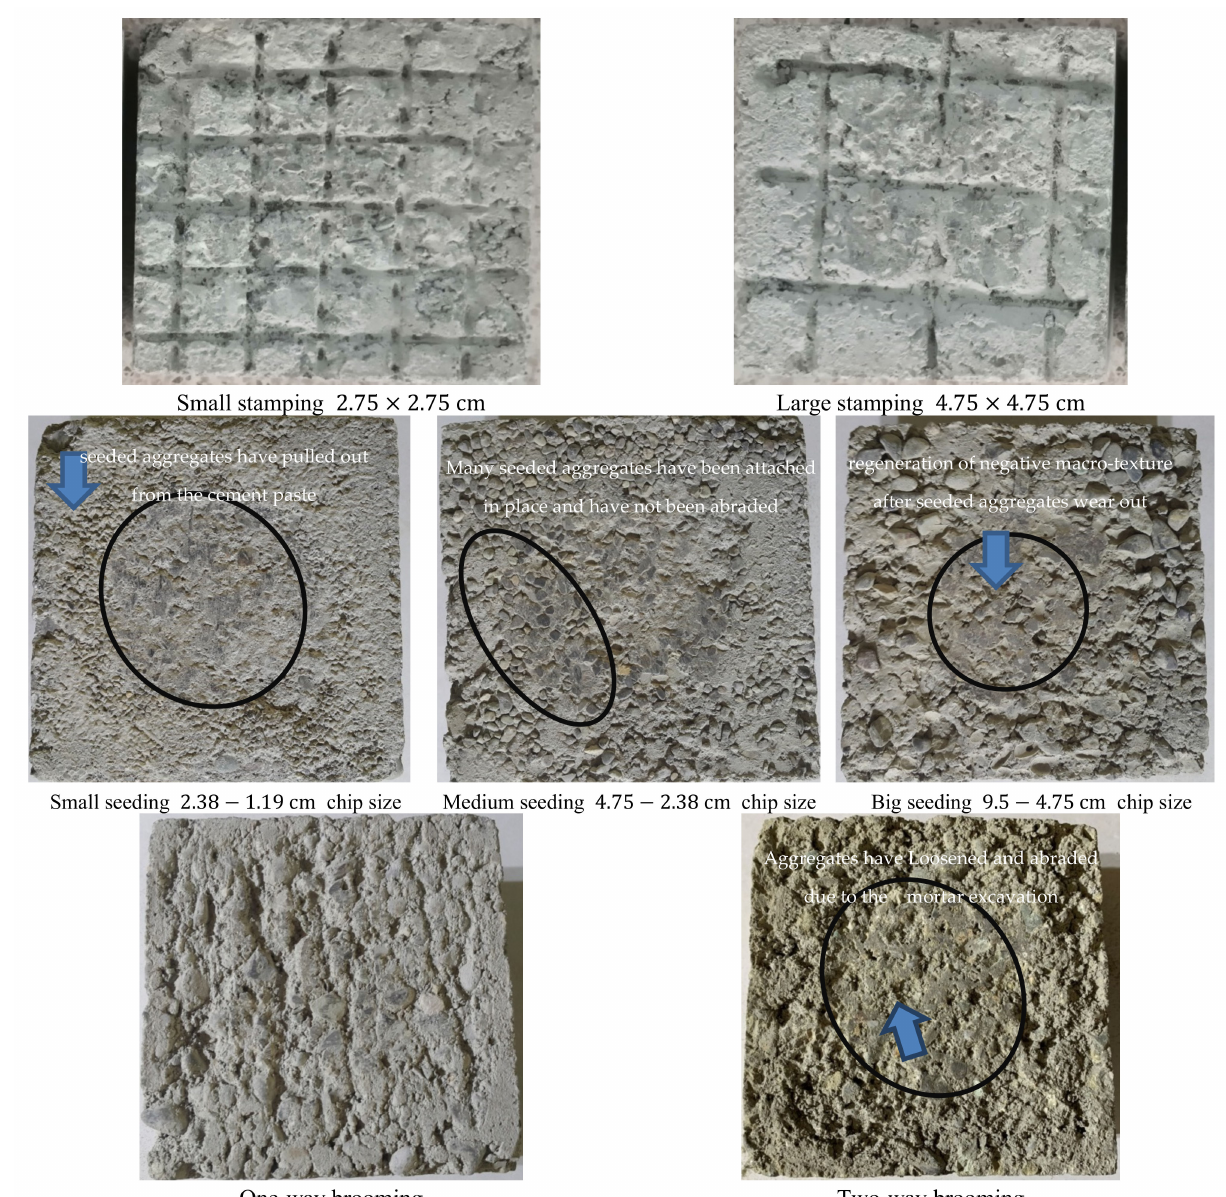
Figure 10. Visual inspection of different